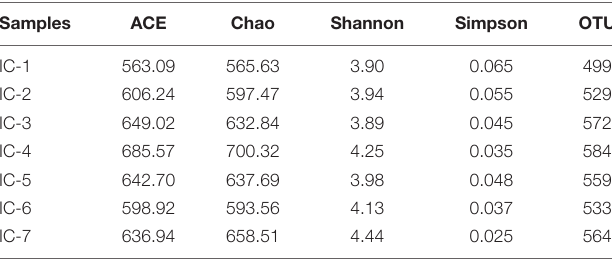
TABLE 1 | Abundance and diversity analysis of bacterial community for clustering at 97% identity.